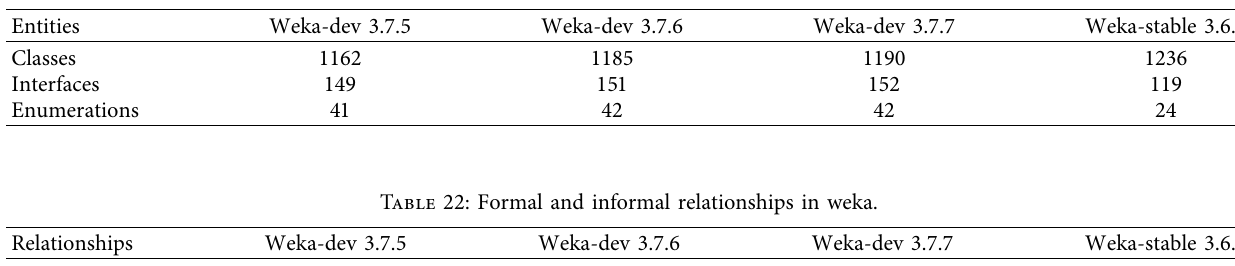
Table 21: Entities in weka.